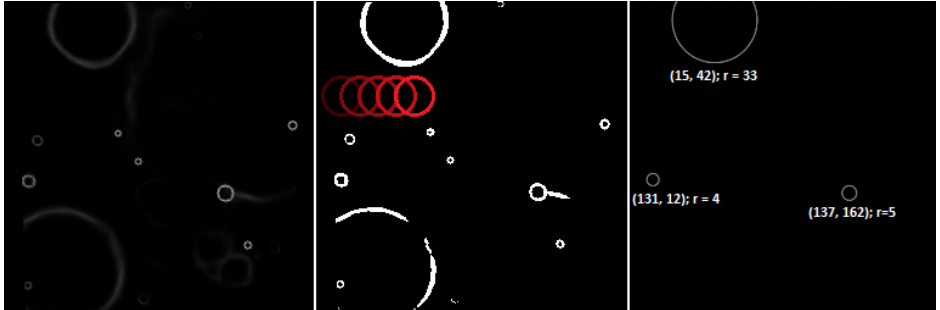
Figure 5. The template matching algorithm utilized in the Deep Moon pipeline. The left image is the input (output of the CNN model). The middle one shows the already quantized mask with the ring sliding across the image (red). The right one shows locations of those craters, for which the correlation between the ring and the image at that place exceeded the threshold and was dominant in their